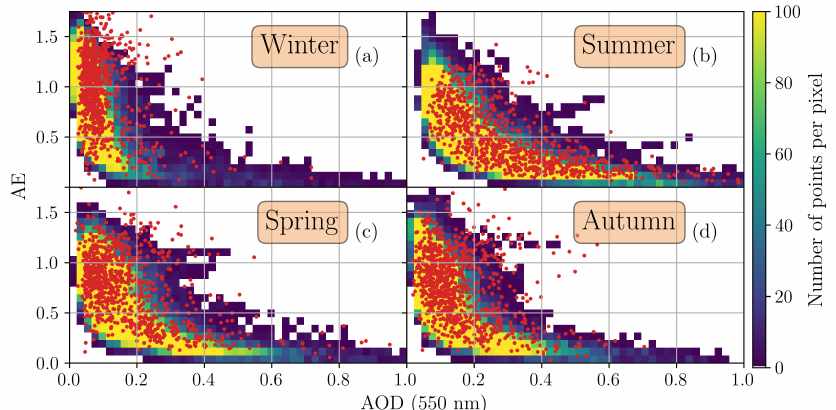
Figure 9. Density number plot between MERRA-2 AOD 550 and AE 470 − 870 per season over Saada: ( a ) Winter, ( b ) Summer, ( c ) Spring and ( d ) Autumn, over which are superimposed AERONET AOD 550 and AE 440 − 870 scatter plots (red dots) for the 2004–2020